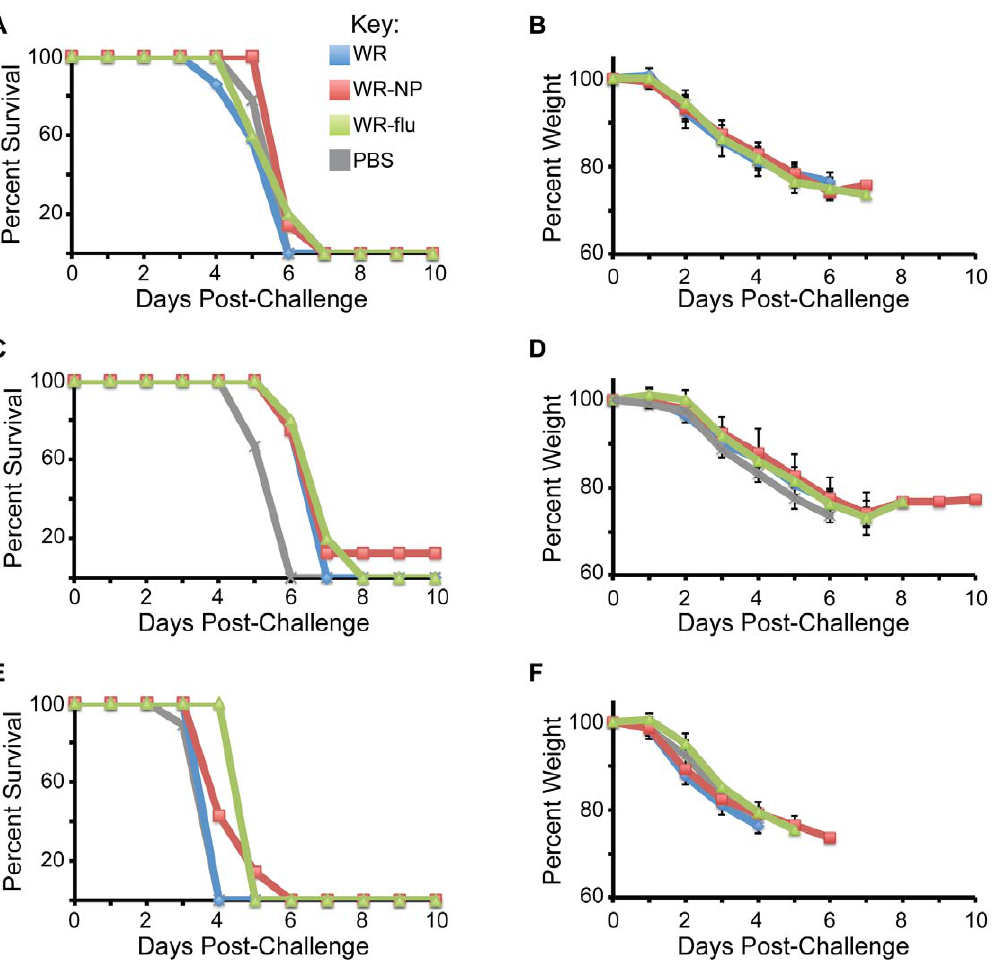
Figure 7. Vaccination delays mortality in influenza virus-challenged mice. Two weeks following the end of the vaccination protocol, 5–8 mice from each vaccination group and 9 mice from control PBS-inoculated animals were infected with 10 6 LD 50 of the A/WSN/33 (A, B), A/PR/8/34 (C, D), or A/California/07/09 (E, F) strains of influenza virus. Mice were sacrificed when body weight reached 75% of starting weight.